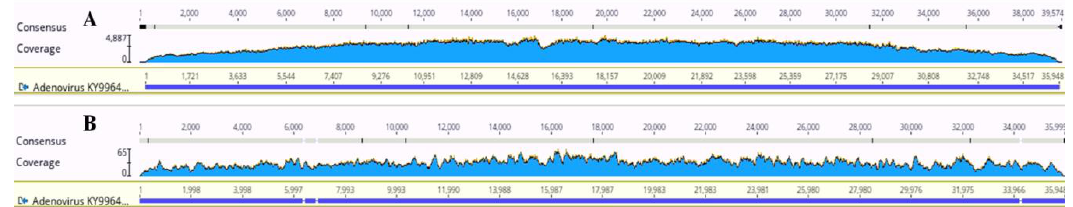
Figure 2. The depth coverage of AdV for the MoBio samples. ( A ) The sample with 5 min of bead beating in the lysis step of extraction. ( B ) The same sample with 25 s × 2 cycles of bead beating.